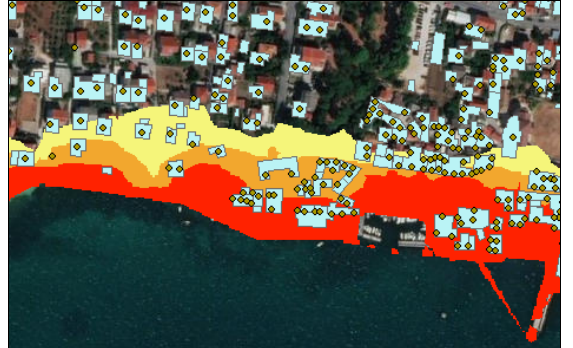
Figure 3. Building footprints and house numbers overlaid with hazard zones